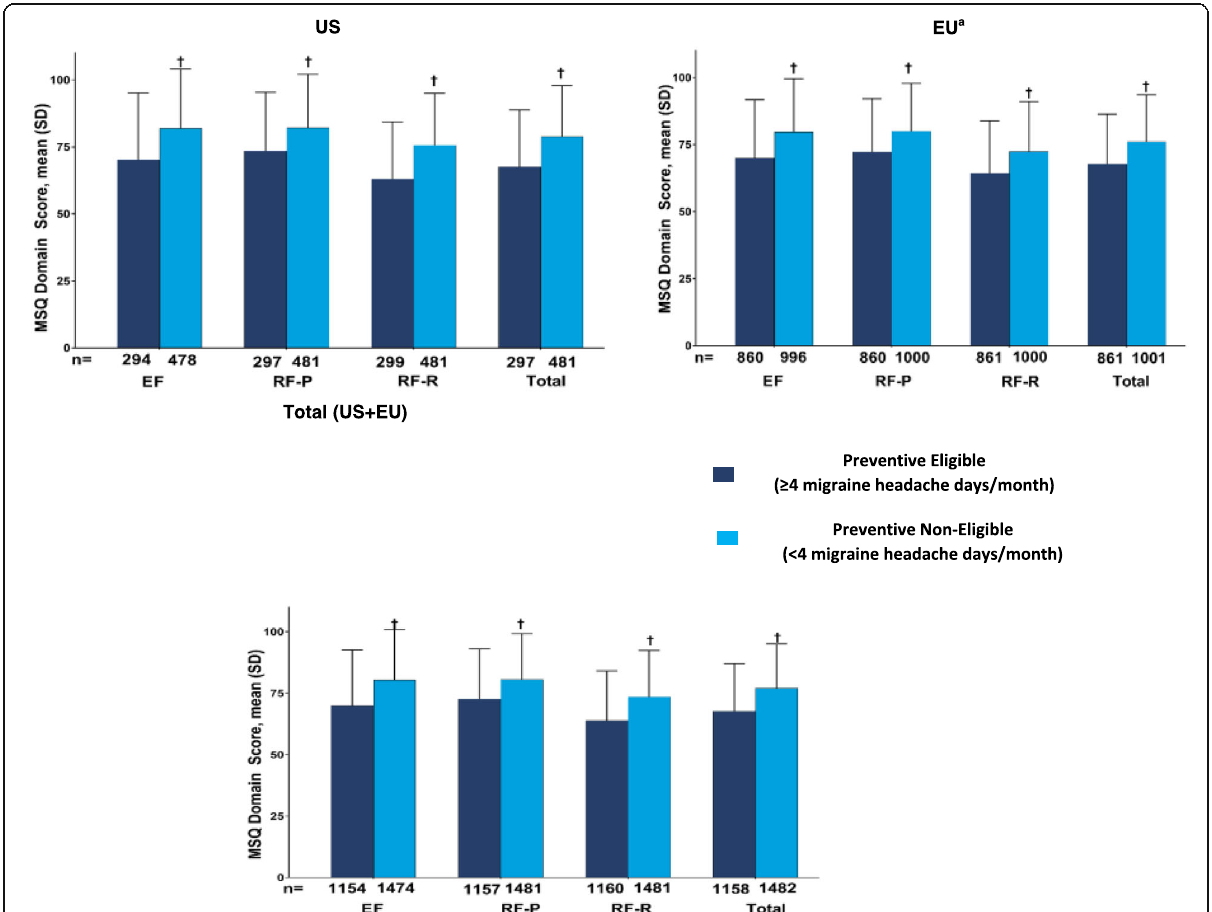
Fig. 1 MSQ domain score, mean (SD) in patients with migraine by preventive treatment eligibility